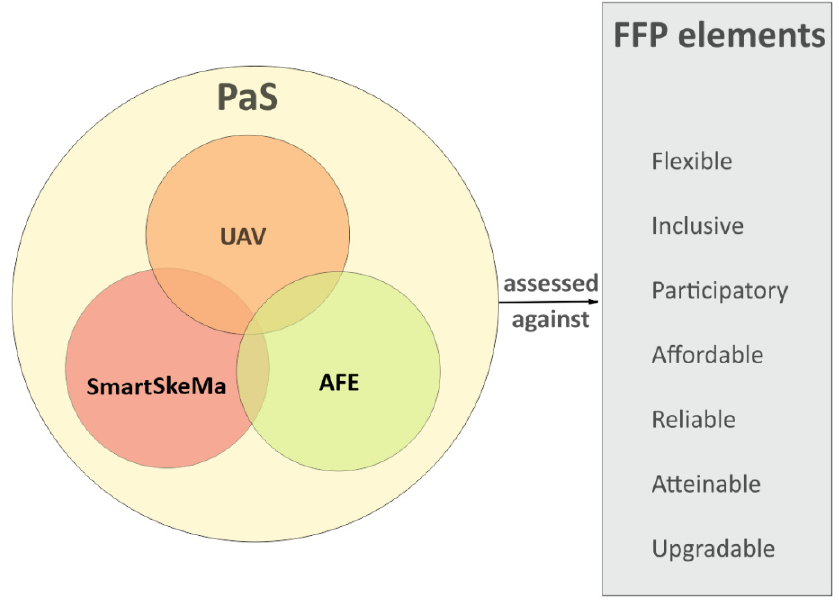
Figure 7. Assessment method.